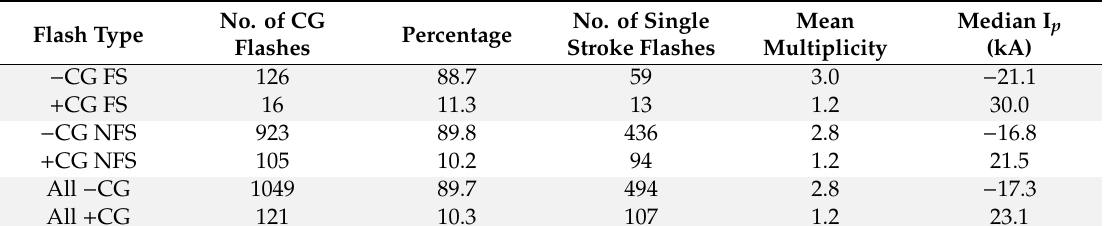
Table 1. Statistics of CG flashes during the 2017 wildfire season of this study. The characteristics include polarity, multiplicity, and peak current of FS and non-fire-starting (NFS) flashes.